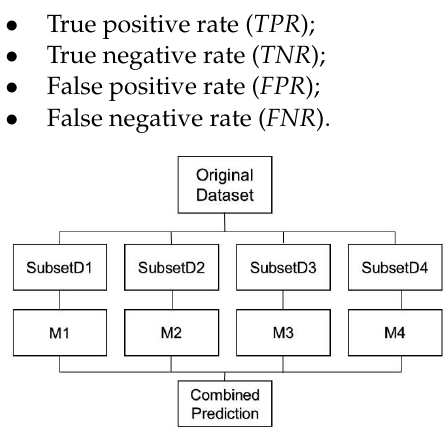
Figure 12. Bagged Trees diagram.